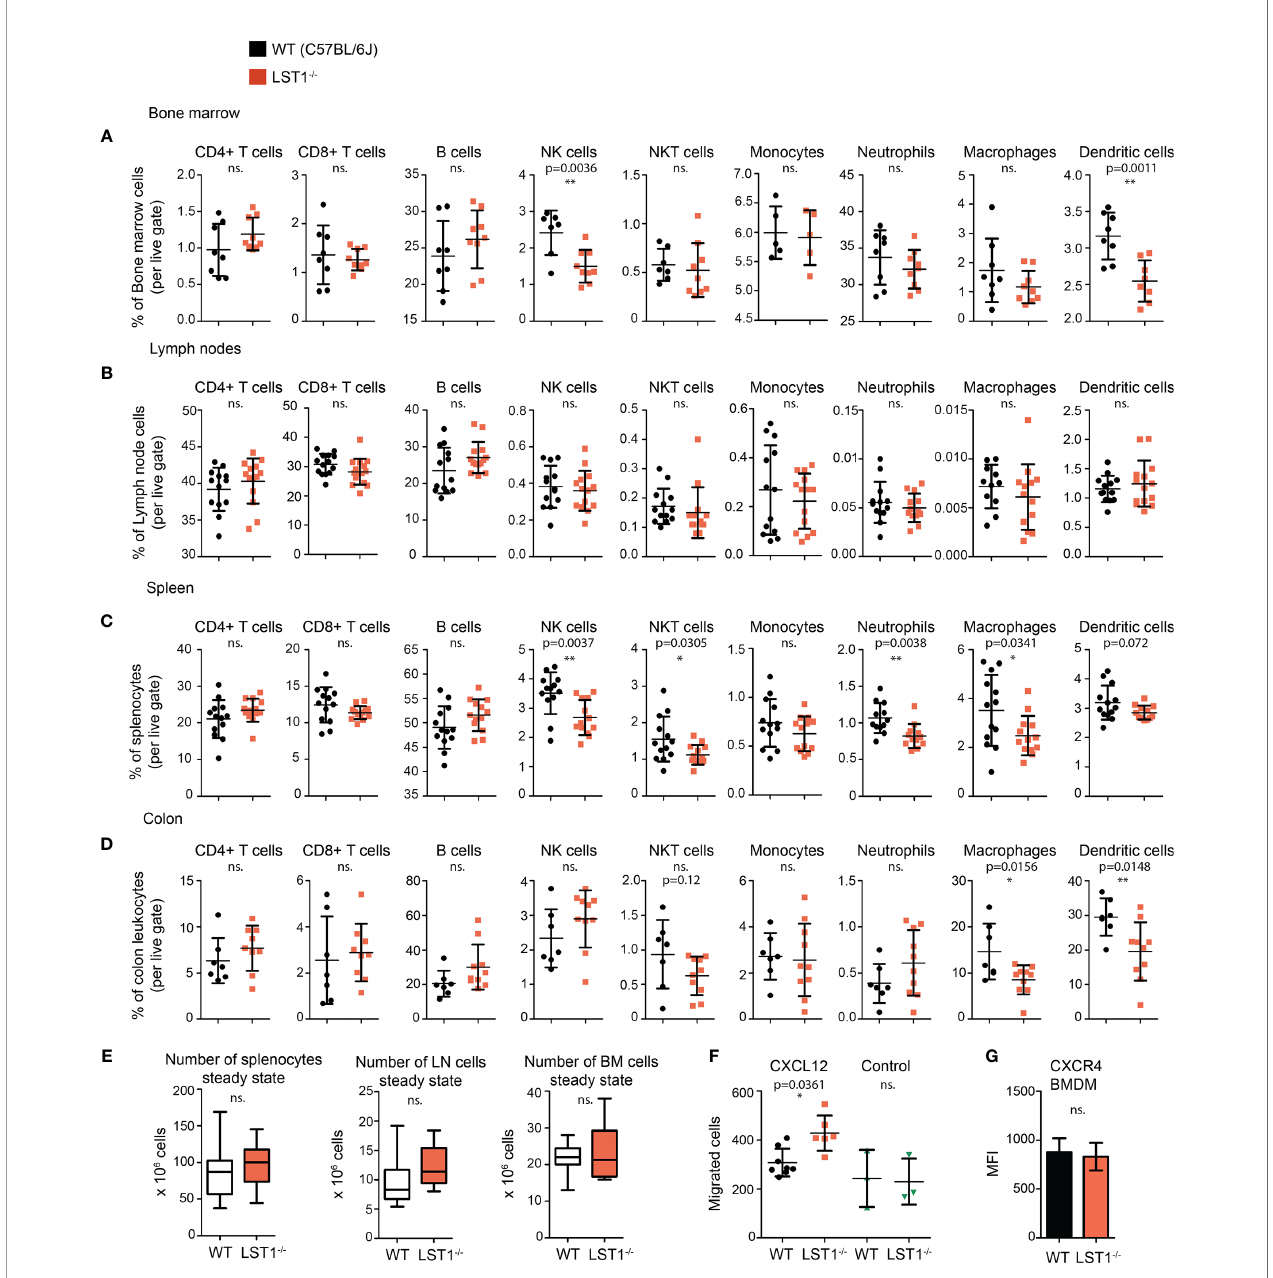
FIGURE 4 | Alterationsof leukocyte subsetpercentages in Lst1 -/- mice. (A – D) Steady state percentages of mainleukocyte subsets (n=5-15) in the bone marrow (A) , lymph nodes (B) , spleen (C) , and colon (D) . Dots in scatter plots represent biological replicates. (E) Absolute numbersof cellsinsteady state spleen,bone marrow and lymph nodes (n=14-25). (F) Number of bone marrow derived macrophages (BMDM) that after 2 hours migrated towards CXCL12 (100 ng/ml) (n=6-8). Controlsamples were withoutCXCL12 chemo-attractant (n=3). (G) Quanti fi cation of CXCR4 expression on BMDM surface (n=6). Dots in scatter plots represent biological replicates. Statistics evaluation was done by Student´s t-test (two-tailed,unpaired) and two-sidedGrubb´s test. *p ≤ 0.05, **p ≤ 0.01, ns, not signi fi